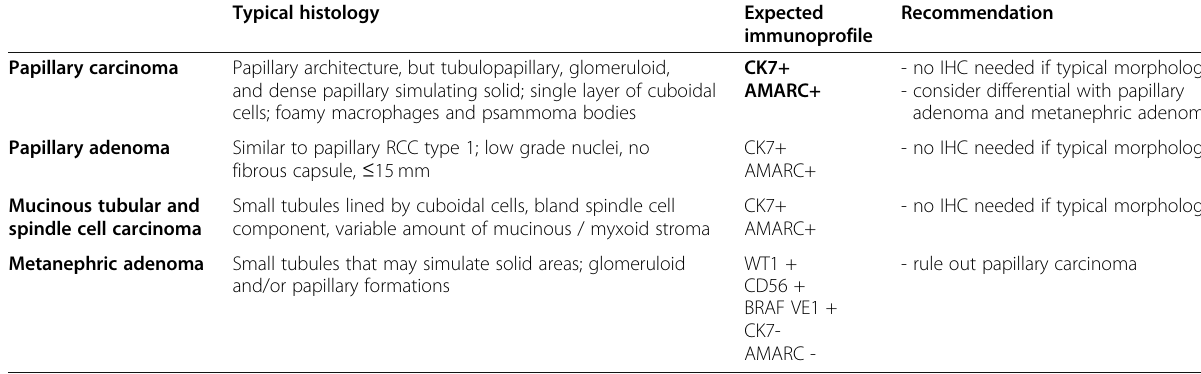
Table 4 Tumors with basophilic